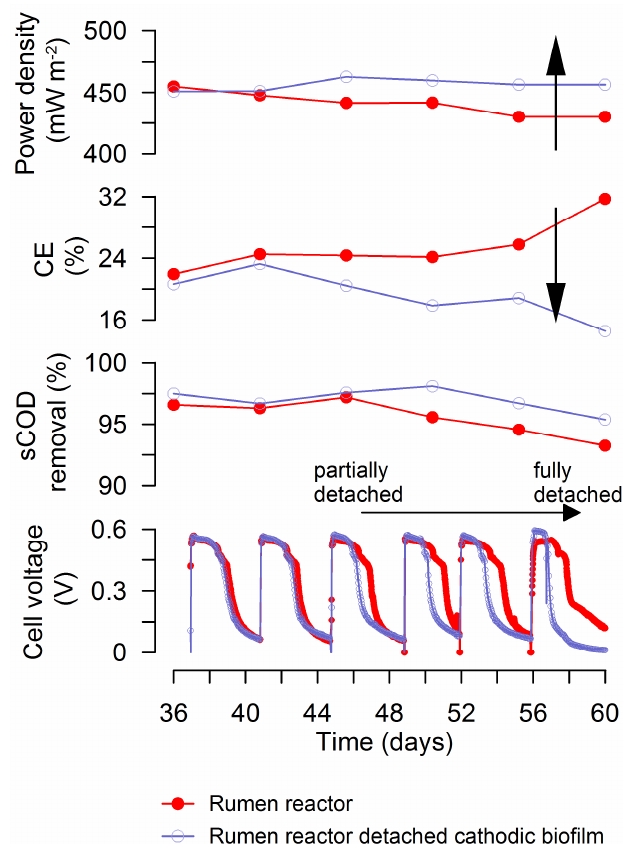
Figure 5. Effect of cathodic biofilm detachment on rumen MFC performance. Loss of the outer part of the cathodic biofilm caused decreases in cell voltages and CE, and slight increases in maximum power densities. Arrows indicate observed trends for Rumen reactors after cathode detachment.